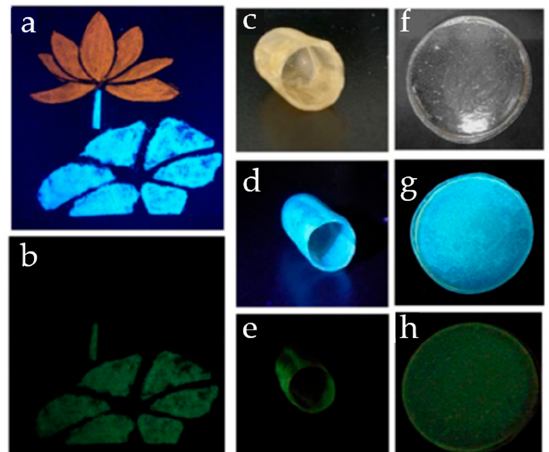
Figure 12. ( a , b ): Security feature of a flower printed with fluorescent dye, with its stem and leaf printed with graphene quantum dots–layered double hydroxide (GQD–LDH) nanocomposite ( a ) under 365 nm light and ( b ) after the UV light was switched off. ( c – h ): Gelatine capsule ( c – e ) and PVA film ( f – h ) containing GQD–LDH composite; ( c , f ) under natural light; ( d , g ) under 365 nm light; and ( e , h ) after the UV light was switched off. Reproduced with permission from reference [60],